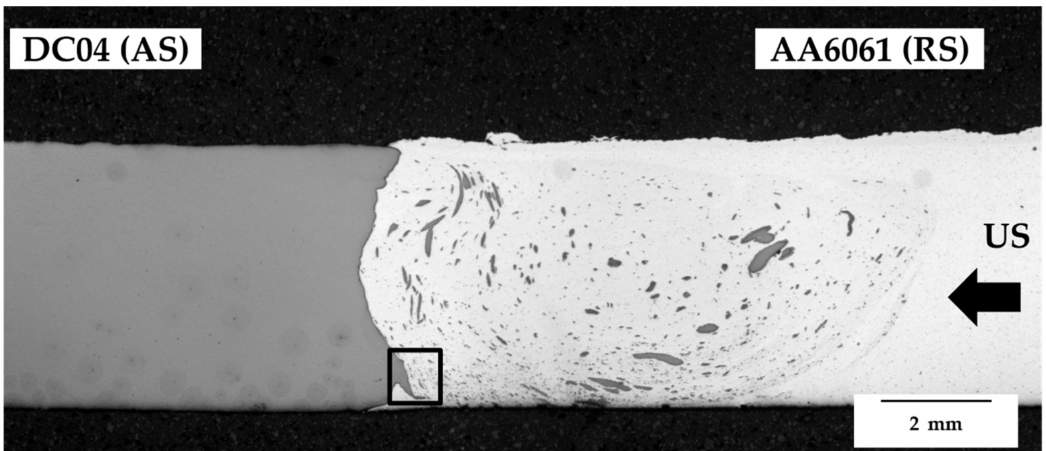
Figure 7. Cross section image of a USE-FSW AA6061 / DC04 joint with ultrasound transmission into